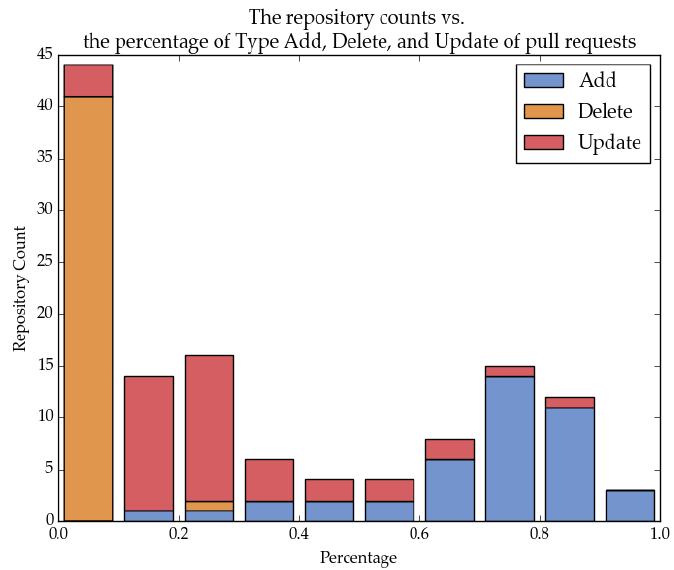
Figure 3. The repository counts versus the percentage of Type Add, Delete, and Update of pull requests.